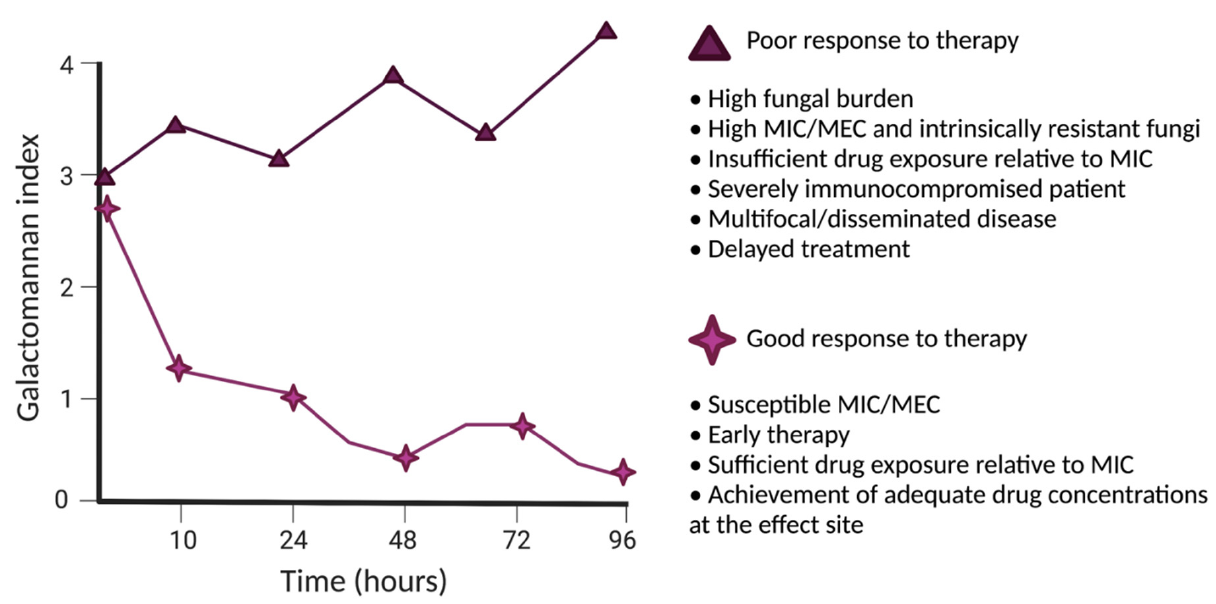
Figure 1. A schematic illustrating the use of a biomarker to guide antifungal therapy. The sold stars and triangles depict a favourable and suboptimal response to antifungal therapy, respectively. Figure created with Biorender.com, accessed on 13 December